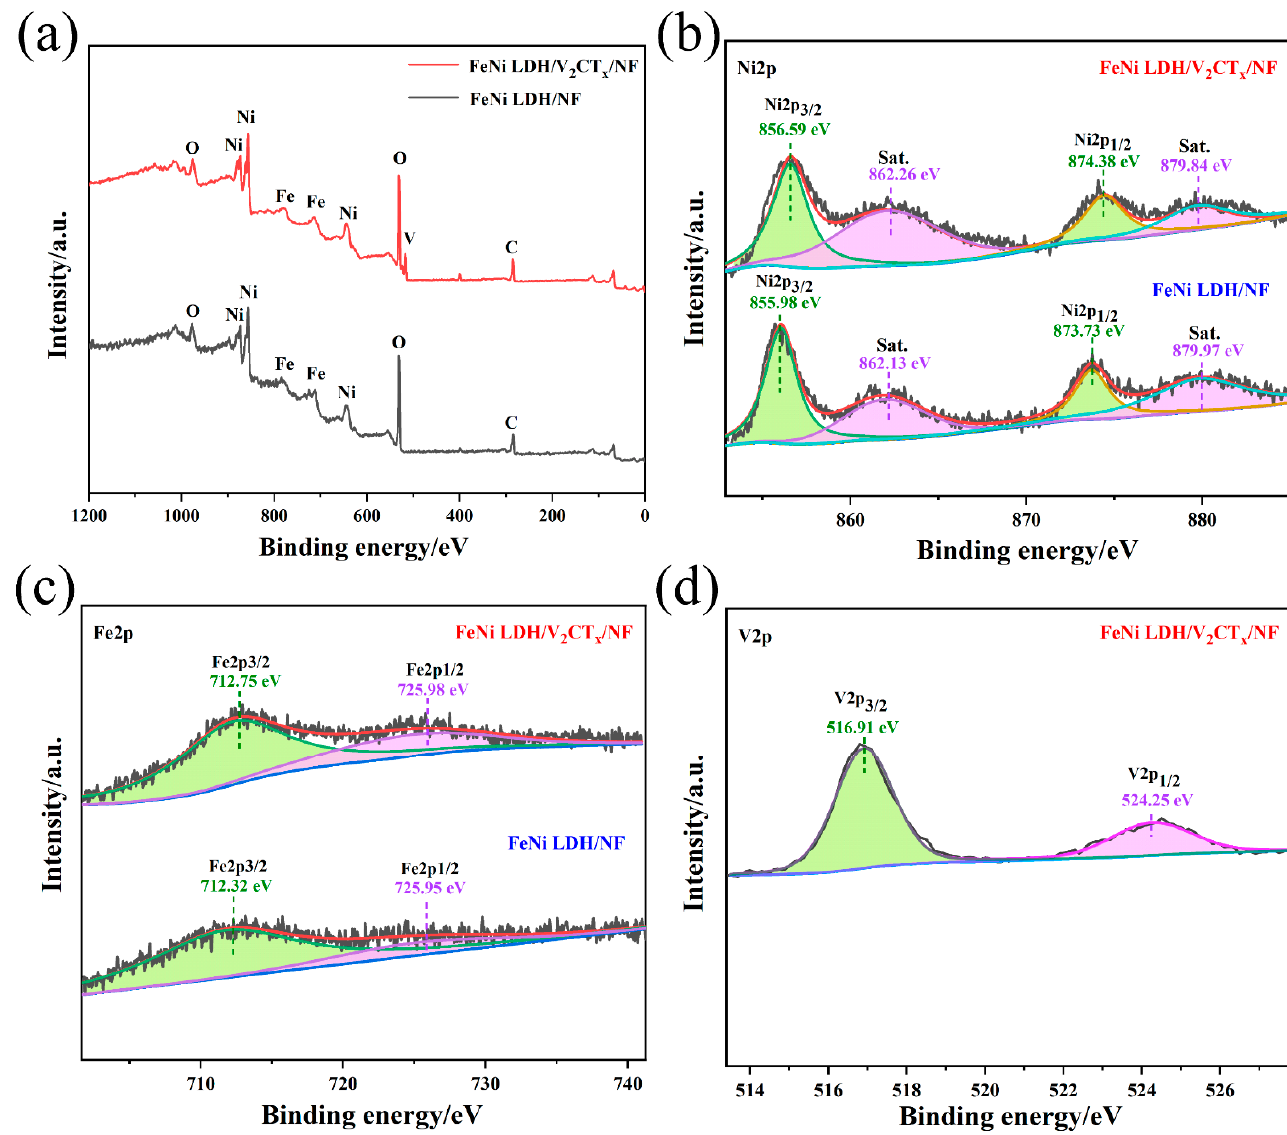
Figure 2. ( a ) Survey spectra of FeNi LDH/V 2 CT x /NF sample; ( b , c ) Ni 2p and Fe 2p XPS spectra of FeNi LDH/NF sample, respectively. ( d ) V 2p XPS spectra of FeNi LDH/V 2 CT x /NF.